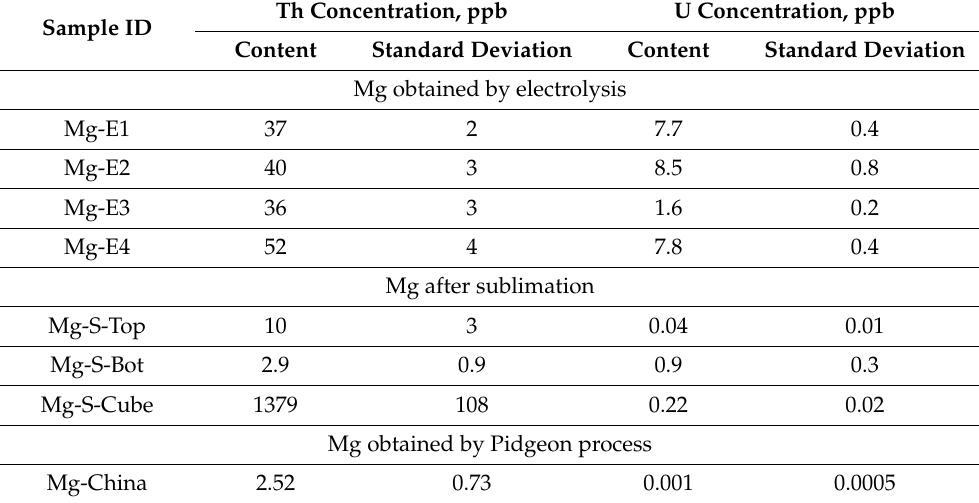
Table 3. The ICP-MS results of